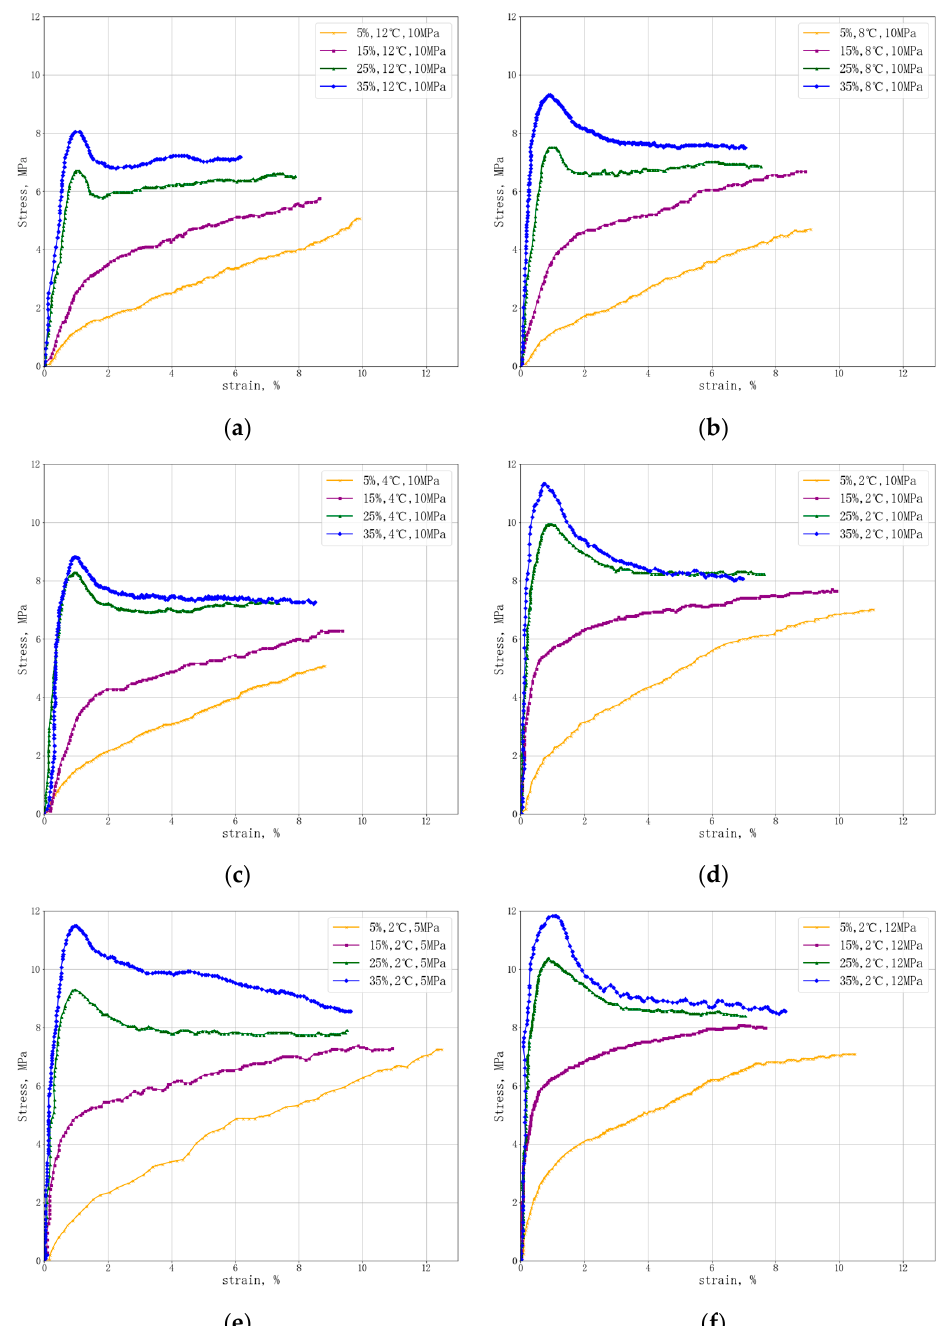
Figure 4. Stress–strain curves under di ff erent temperature and pressure conditions. ( a ) Stress–strain curves at 12 °C and 10 MPa. ( b ) Stress–strain curves at 8 °C and 10 MPa. ( c ) Stress–strain curves at 4 °C and 10 MPa. ( d ) Stress–strain curves at 2 °C and 10 MPa. ( e ) Stress–strain curves at 2 °C and 5 MPa. ( f ) Stress–strain curves at 2 °C and 12 MPa. 3.2. Triaxial Shear Test of Hydrate Sediments with Di ff erent Saturations under Di ff erent Net Con fi ning Pressure Conditions (1) Stress–strain curves of di ff erent hydrate saturations under di ff erent net con fi ning pressures